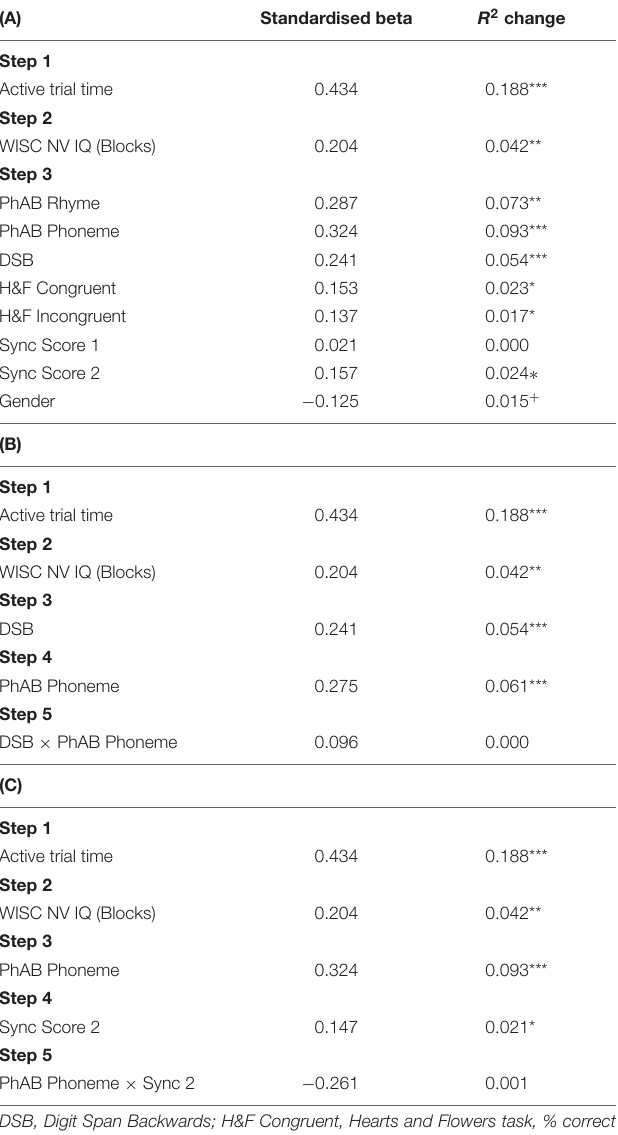
TABLE 3 | Unique variance ( R 2 change) in progression through GG Rime explained by the different neurocognitive predictors measured prior to the